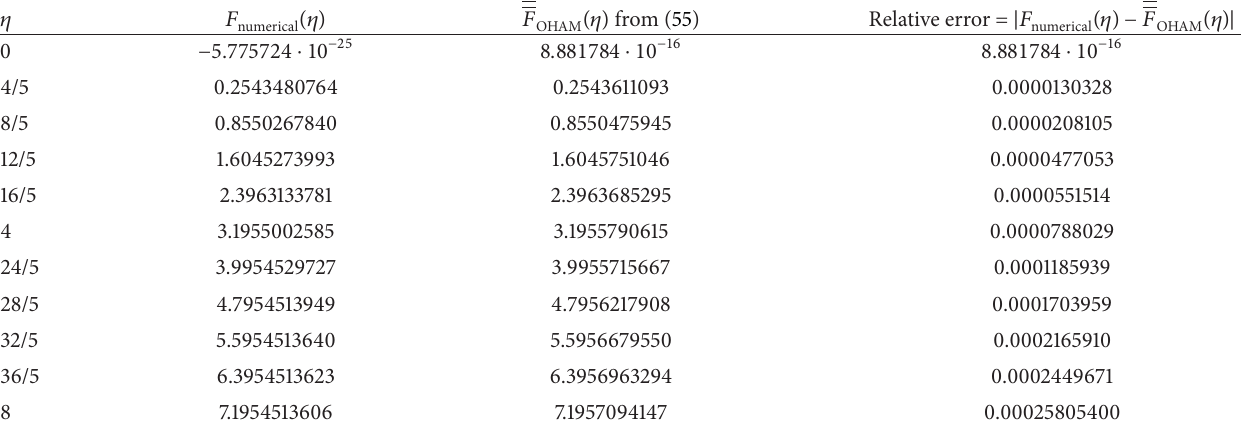
Table 8: Comparison between OHAM results for velocity 𝐹 𝜂 𝐹 󸀠 (𝜂) numerical